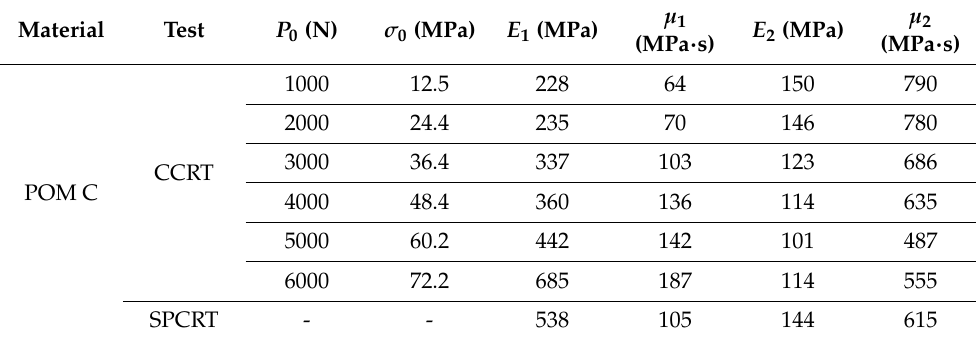
Figure 9. SPCRTs: registered punch displacement for the evaluated polymers. Table 3. Coefficients of Maxwell-Wiechert model for the evaluated